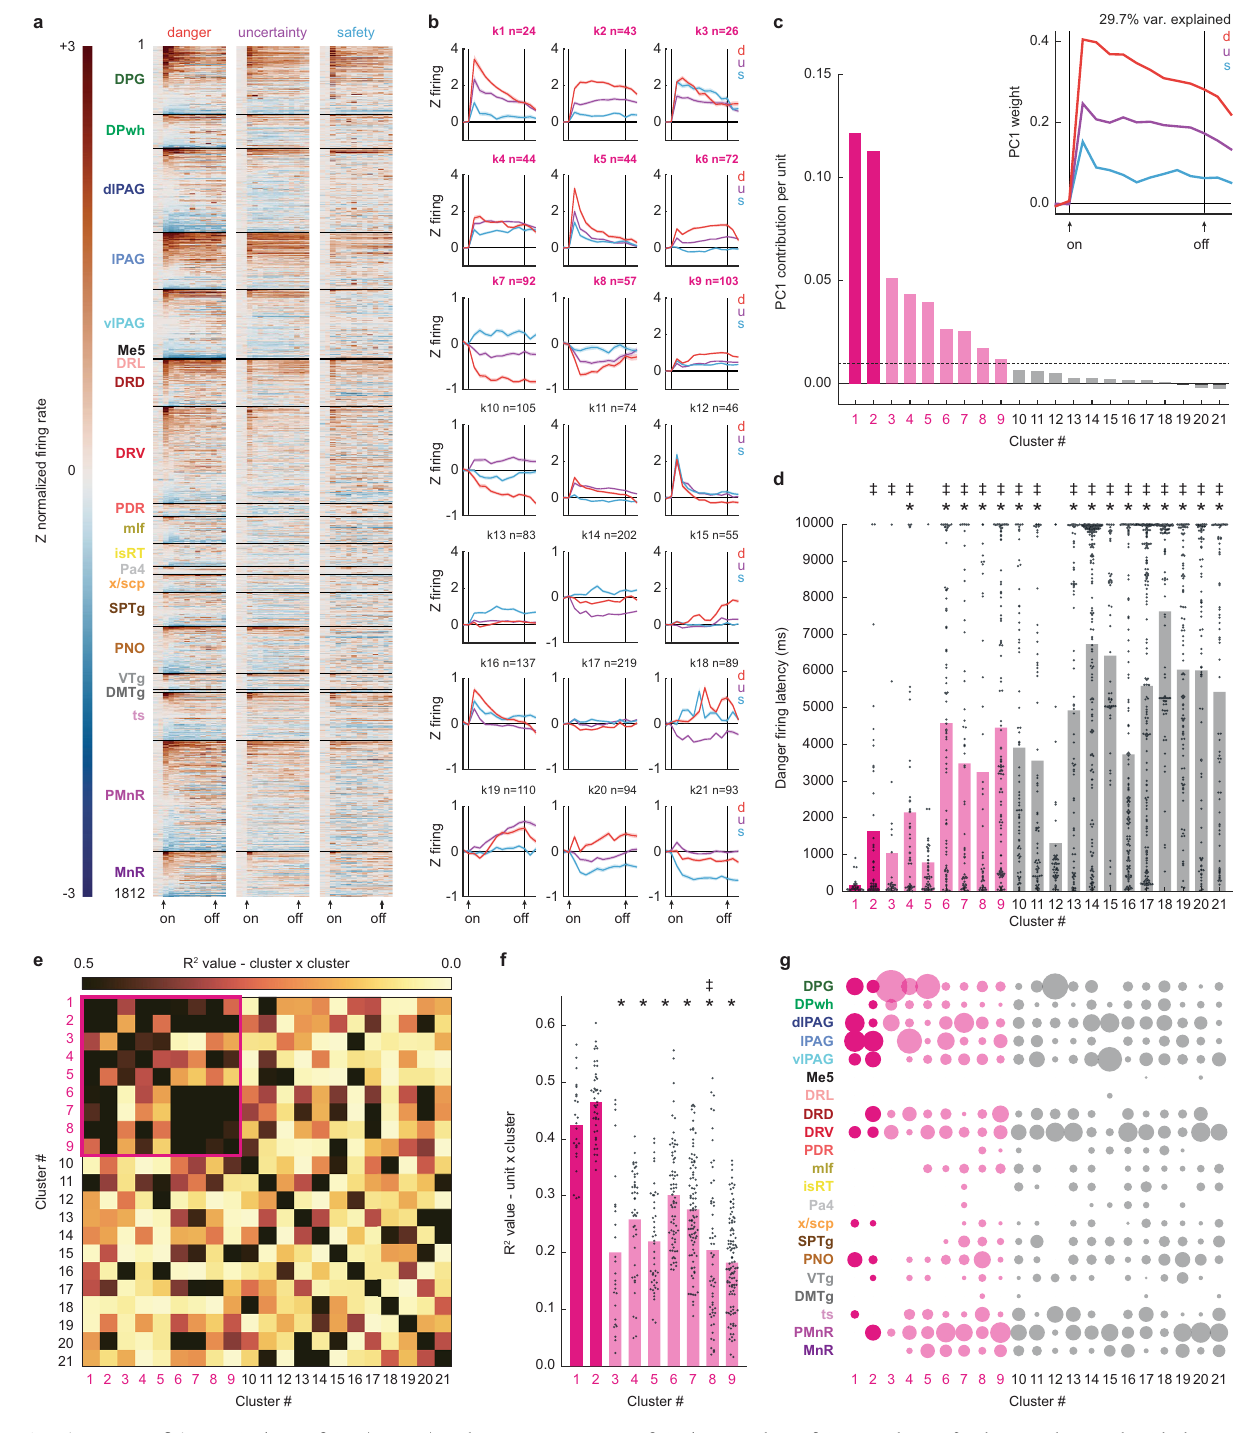
Fig. 2 | Brainstem cue fi ring. a Single-unit fi ring ( n =1812) to danger, uncertainty, andsafetycuesorganizedbybrainregion,dorsaltoventral. b Meancluster(k1 – k21) fi ring over cue presentation (cluster n shown in the fi gure). Data are presented as meanvalues±SEM. c PC1forbrainstemcue fi ring(inset)andclustercontributionto PC1. d Single-unit danger fi ring latency with cluster means. e Between-cluster cue fi ring correlations (data from b ). Cue subnetwork outlined in magenta.